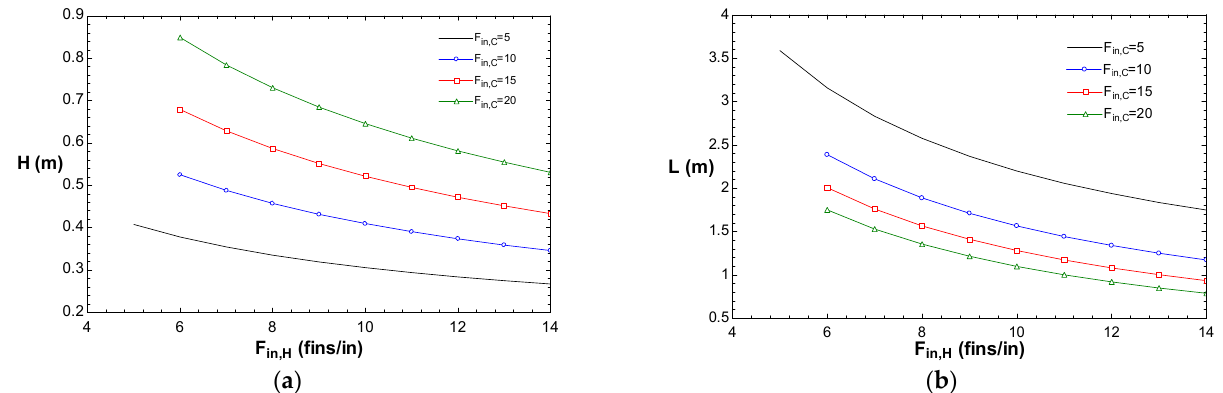
Figure 7. Fin density for hot and cold streams vs. heat exchanger dimensions using offset surfaces: ( a ) height vs. fin density ( b ) length vs. fin density.